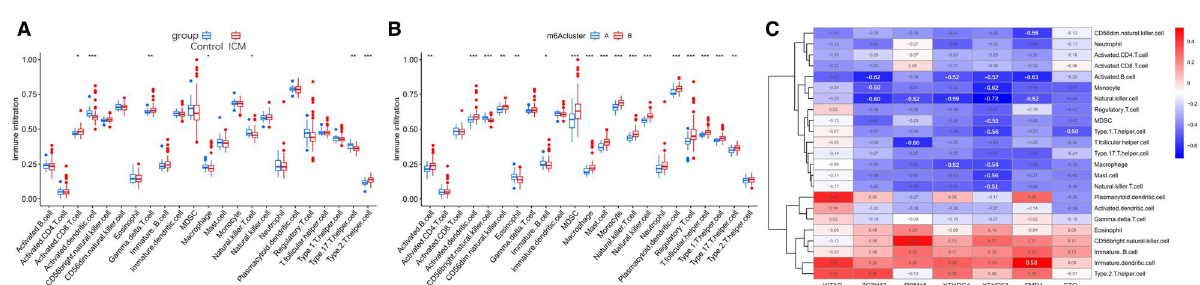
Figure 5. Diversity of immune microenvironment characteristics among the two distinct m6A modification patterns. The differences in the abundances of each immune microenvironment-infiltrating immunocyte between control and ICM samples ( A ); m6A cluster-A and -B ( B ). ( C ) The associations between 7 key m6A regulators and several immune cells. *, P < 0.05; **, P < 0.01; ***, P < cells, T follicular helper cells, and Th17 cells were low, while the number of infiltrated immature dendritic cells were high in the high YTHDF3 expression group (Fig. 6A). Similar patterns of immune cell infiltration were found between the high and low expression groups of FMR1 (Fig. 6B), ZC3H13 (Fig. 6C), RBM15 (Fig. 6D), YTHDC1 (Fig. 6E), and FTO (Fig. 6F). In addition, we noted that the expression levels of HLA-A, HLA-DMA, HLA-DMB, HLA-DPA1, and HLA-DPB1 were significantly elevated in ICM patients than in control subjects (Fig. 7A). We also found that the expression levels of HLA-DMA, HLA-A, HLA-DQA1, HLA-B, HLA-DPA1, m6A cluster-B group, compared with the m6A cluster-A group (Fig. 7B). Biological characteristics of healthy subjects and ICM patients. The HALLMARKS pathways between healthy subjects and ICM patients were compared via gene set variation analysis (GSVA). Compared with the m6A cluster-A group, the m6A cluster-B group had a larger number of enriched pathways, such as the TNF-a signalling pathway via NF-kB, apoptosis, the apical junction, the apical surface, cholesterol homeostasis, the late estrogen response, the interferon gamma response, glycolysis, IL-6/JAK/STAT3 signalling pathway, the interferon alpha response, UV response up, myogenesis, hypoxia, TGF-β signalling, epithelial mesenchymal